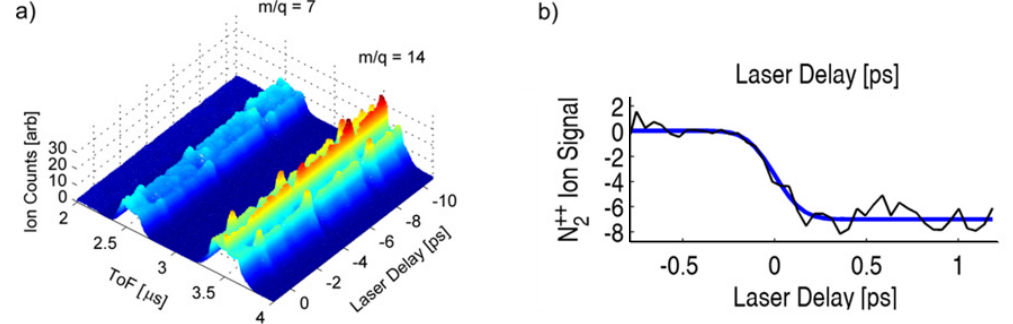
Figure 4. Periodic quantum alignement of nitrogen molecules are viewed here through their dissociation. a) Pump- probe time-delay dependent ion time-of-flight (ToF) spectra of molecular nitrogen. The two ridges correspond to fragments; and m / q = 7, at 2.5 (cid:5) s, which shows the ToF spectrum near m / q = 14 at 3.5 (cid:5) s, showing N + and N ++ 2 the N ++ fragments. The width of these features is due to the dissociation kinetic energy of the atomic fragments. Negative delay indicates that the optical pulse precedes the x-ray pulse. Periodic rotational alignment features are clearly visible in all peak structures. b) A lineout at the position of the molecular dication N ++ , which shows how 2 it becomes depleted if the x-rays precede the laser field. This is due to laser-induced dissociation of the dications formed by the x-rays